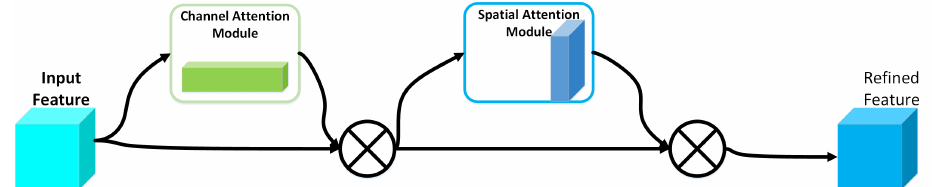
Figure 3. The structure of